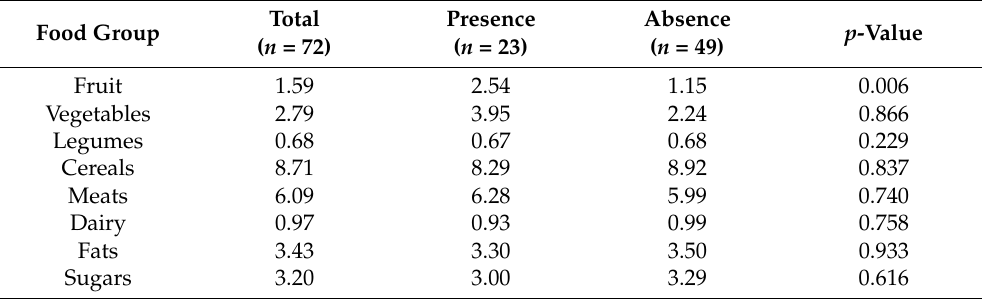
Table 3. Food consumption in the presence of hypoalphalipoproteinemia. Total Food Group